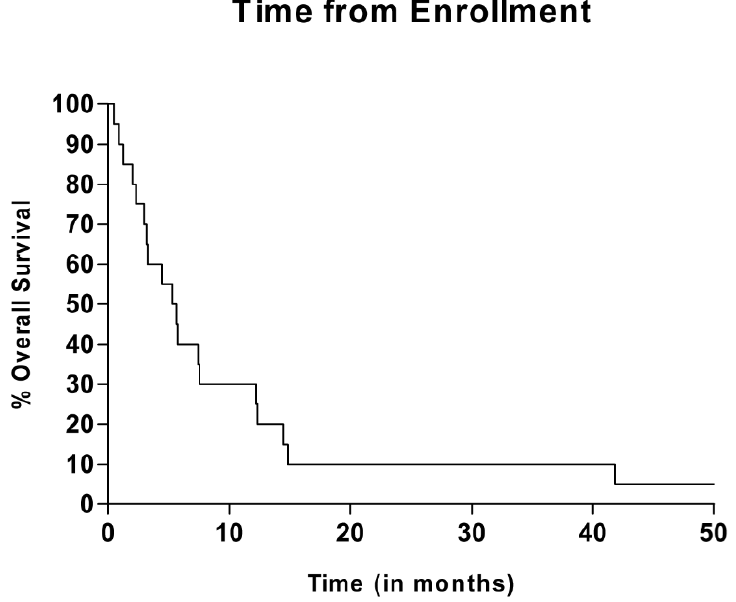
Figure 1. Overall Survival with Temozolomide and Calcitriol in Metastatic Melanoma.